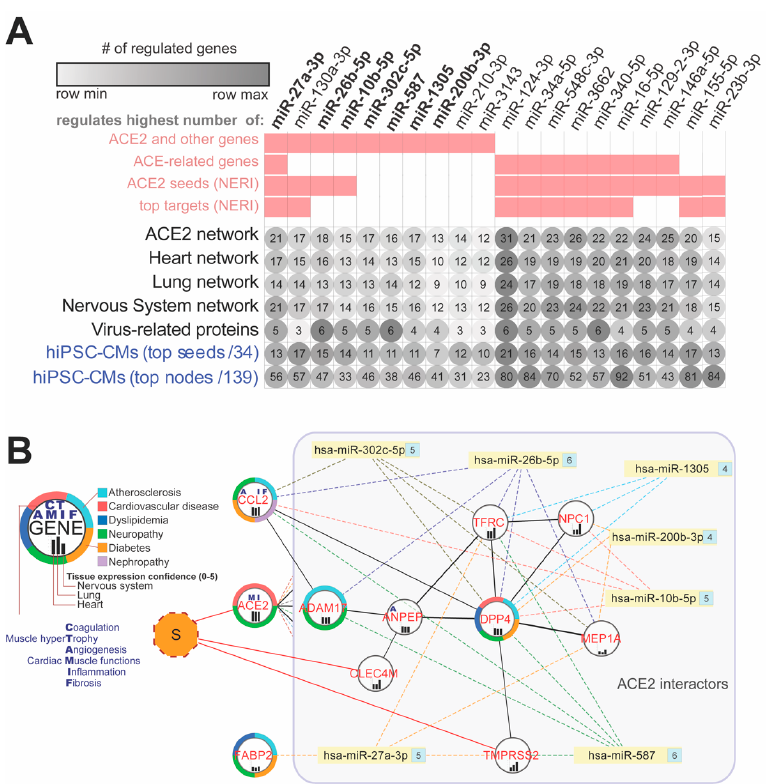
Figure 8. Top 20 potential miRNA modulators of the ACE2 network in COVID-19. ( A ) Top miRNAs regulating the highest number of genes within all ACE2 related-networks. Pink squares are showing if miRNA was present among the top 10 miRNAs in a given dataset. ( B ) Interaction network between virus-infection related proteins (red labels) and top miRNAs (bolded label on the A panel) regulating ACE2 and shared between analyzed networks and regulating at least four virus-related proteins from the complete network. Numbers on the right side of the miRNAs depict the number of targeted genes within the network. CCL2 and FABP2 genes are not direct interactors of the ACE2, so they are presented outside of the ACE2-interactors box. “S” refers to SARS-CoV-2 spike glycoprotein S. Human-induced pluripotent stem cell-derived cardiomyocytes (hiPSC-CMs).